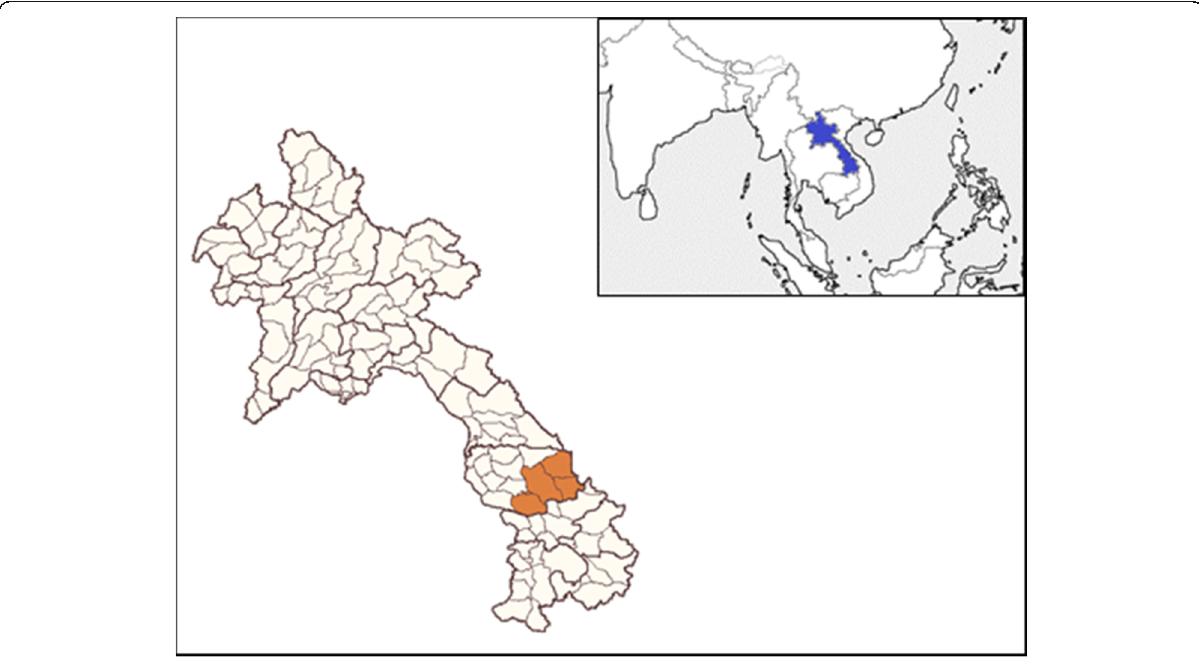
Fig. 1 Map of the Lao PDR and the study districts. The small map insert at the upper right shows the location of the Lao PDR highlighted in blue. The large map shows the location of the four study districts of Thapangthong, Nong, Xepon, and Phin highlighted in